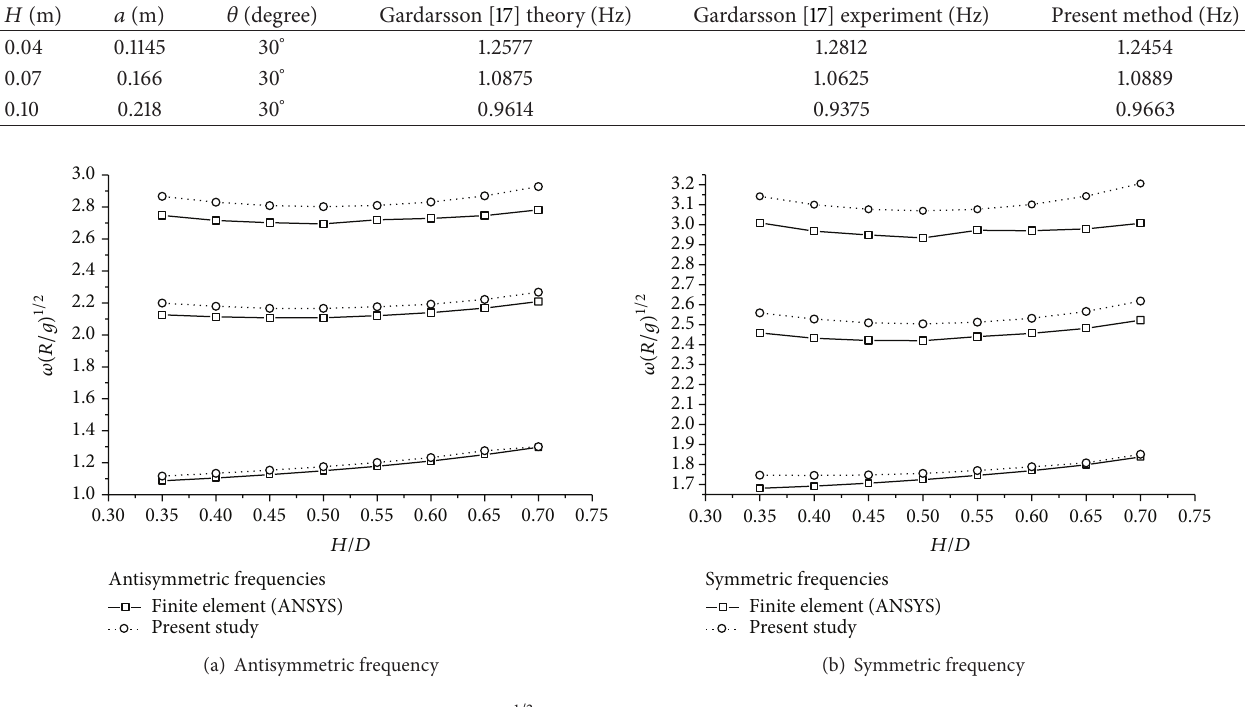
Figure 7: Variation 𝜔(𝑅/𝑔) 1/2 with liquid-depth ratio 𝐻/𝐷 (circular aqueduct).